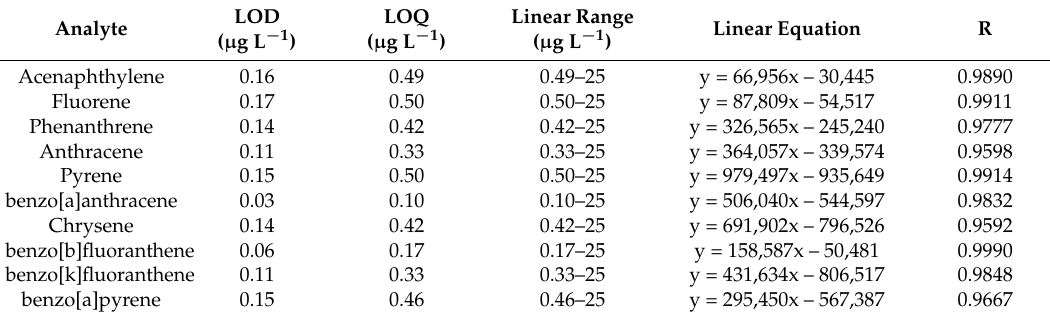
Table 2. The linear range, linear equation, linearity, and limits of detection and quantification for the method developed using diatomaceous earth coating.